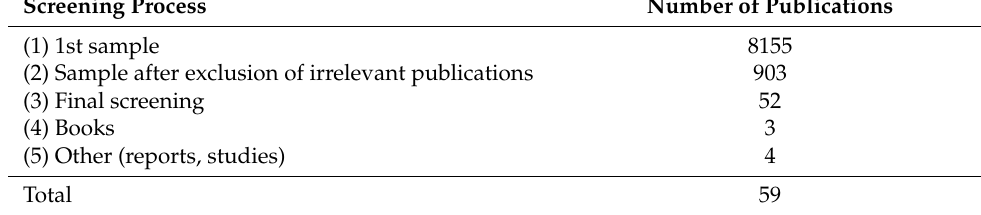
Table 1. Screening of articles on the theme “slow pyrolysis of agricultural and agro-industrial waste”. Screening Process